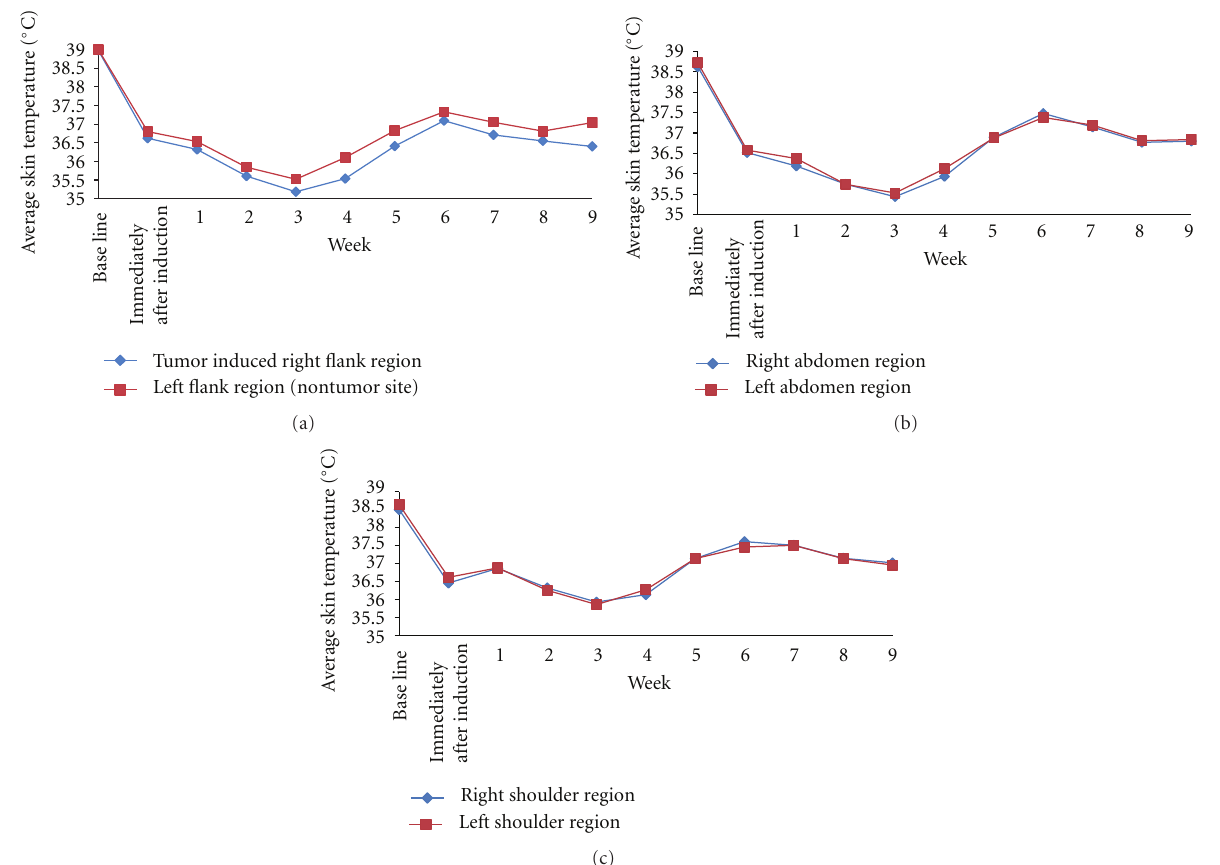
Figure 1: Average skin temperature in di ff erent regions (a) in the tumor induced lower flank region, (b) in the abdomen region, and (c) in the shoulder region. Mean ± SD temperature values (week wise) for 6 tumor induced rats from the specific ROIs of right and left side for all regions (lower flank region, abdomen region, and shoulder region) were plotted. There was di ff erence in temperature observed between right and left flank regions. Tumor induced right side (lower right flank side) temperature was less in all the weeks. There was no di ff erence in temperature observed between right and left side of abdomen and shoulder regions.